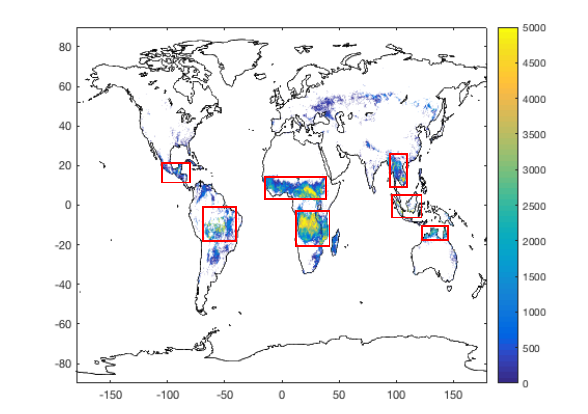
Figure 1. Global map of GFED total carbon emissions from 2000 through 2018 (carbon total emissions greater than 190 g/m 2 and every year containing a carbon emission greater than 0.5 g/m 2 ); Note the red boxes constrain the regions of interest used in this